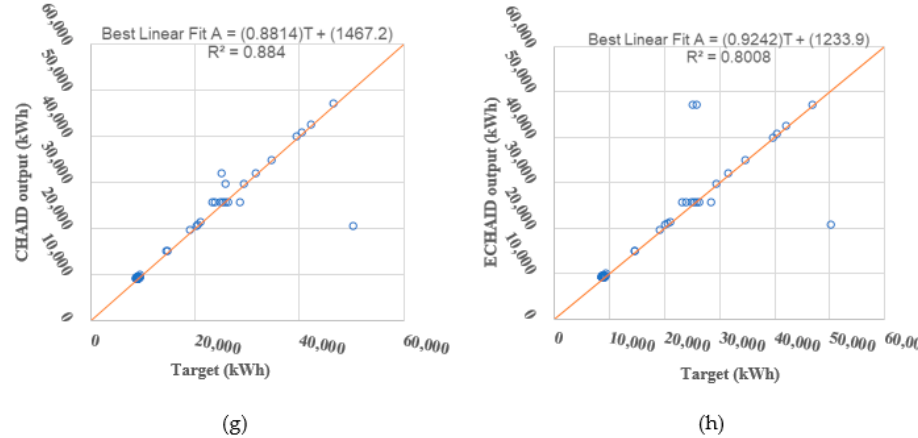
Figure 2. Regression between predicted and simulated electricity consumption: ( a ) MLR model vs. ( b ) BPNN model vs. ( c ) SVM vs. ( d ) BPNN model vs. ( e ) RNFN model vs. ( f ) CART model vs. ( g ) CHAID vs. ( h ) ECHAID model.